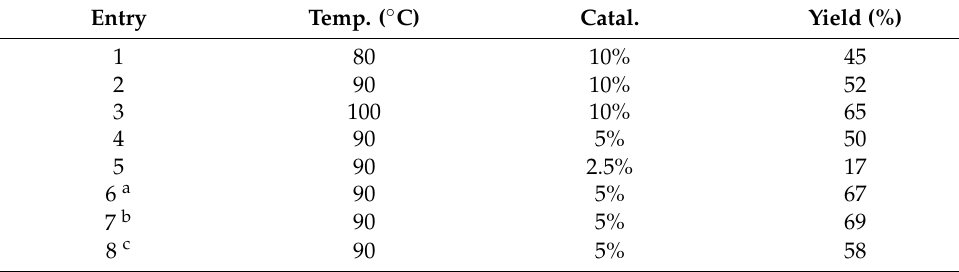
Table 2. Conditions screening for the synthesis of FDCA-bis-CC through transesterification. Entry